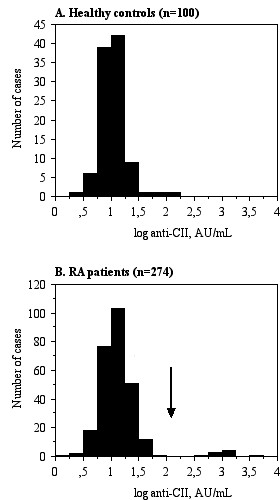
Distribution of anti-native human collagen type II (anti-CII) antibodies. A) the distribution of anti-CII antibodies among 100 healthy blood donors is shown; B) the distribution of anti-CII antibodies among 274 patients with RA [7]; radiological data were available for 256 of these patients. The vertical arrow represents the cutoff value separating the majority of patients with rheumatoid arthritis (RA) and the discrete group with very high anti-CII levels associated with cytokine production in our in vitro immune complex assay [7,8].